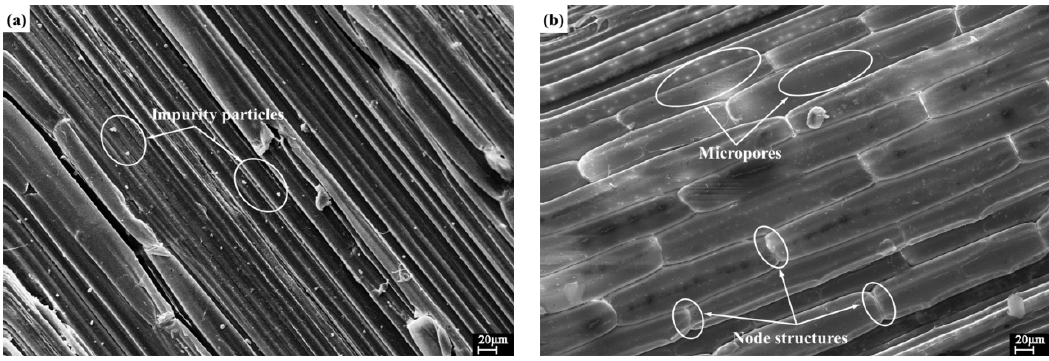
Figure 3. Micrographs of ( a ) raw and ( b ) treated corn stalk fibers.